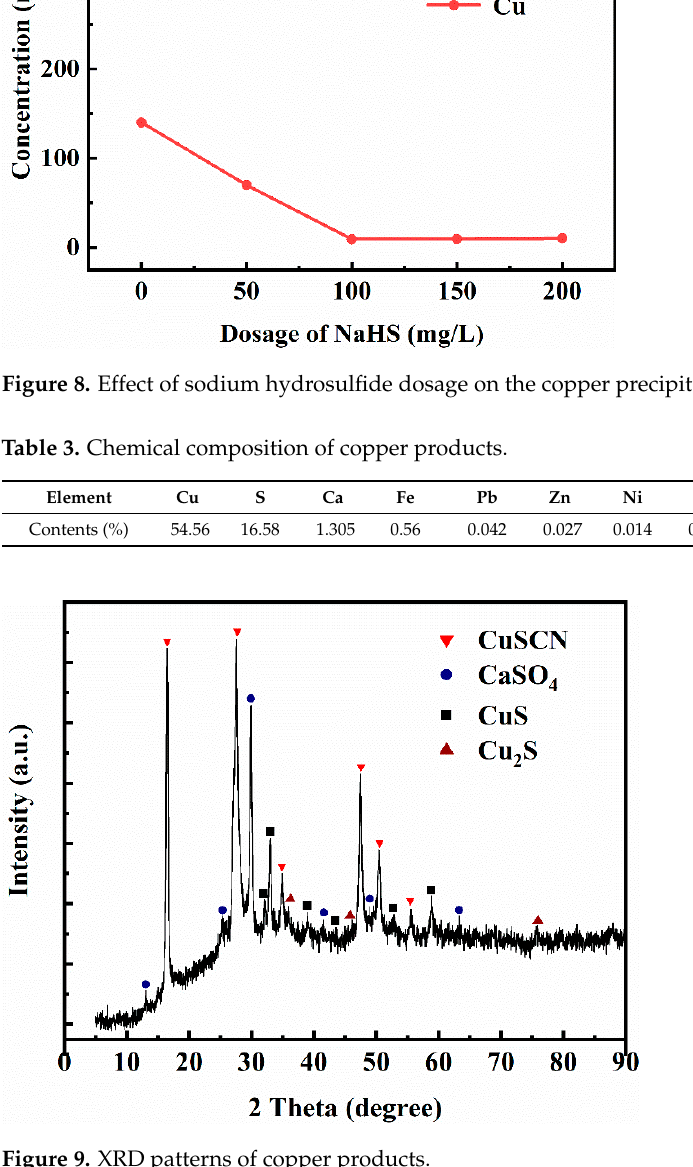
Figure 10. XPS spectra of copper products: ( a ) survey; ( b ) copper; ( c ) sulfur; ( d ) nitrogen. 3.4. Membrane Treatment Process 3.4.1. The Influence of Gaseous Membrane Stages The influence of the number of membrane stages on the effect of membrane treatment was studied under the conditions of 0.3 m 3 /h of cyanide-containing water and 0.6 m 3 /h of lye side flow. Figure 11 indicates that when the flow rate of cyanine-containing water was 0.3 m 3 /h, the total cyanide concentration in the solution could be reduced from 421.21 mg/L to 9.26 mg/L through the primary membrane treatment. After a two-stage mem- brane treatment, the total cyanide concentration was 1.24 mg/L, and with a continued in- crease in the stage of membrane, the total cyanide concentration changed little. In order to ensure the effect of the filter press backwash, the total cyanide content in the cyanide- containing water should be reduced as much as possible, so the number of membrane stages should be 2.